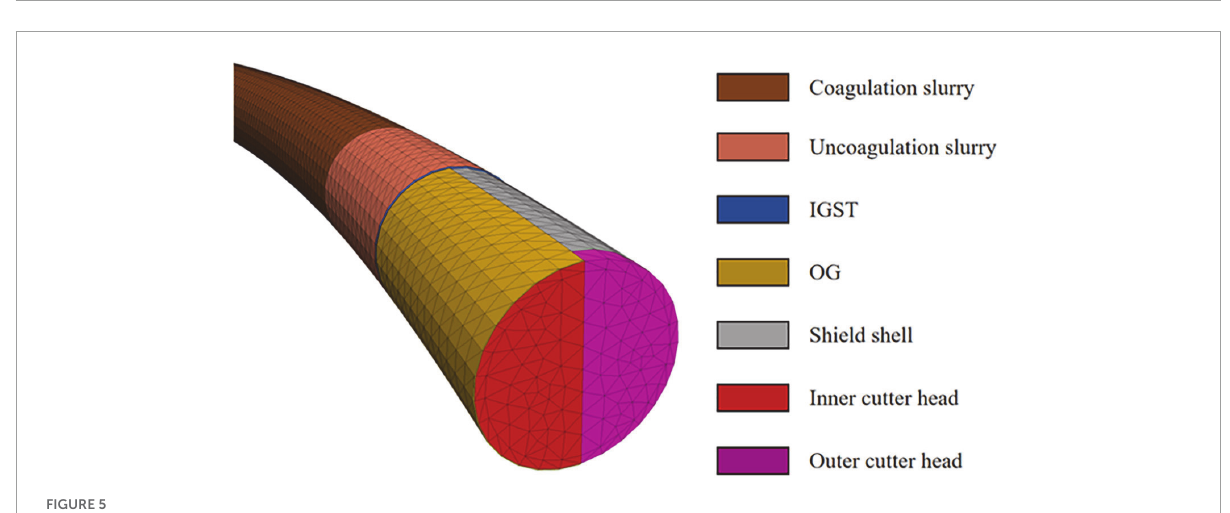
FIGURE5 Shield tunnel